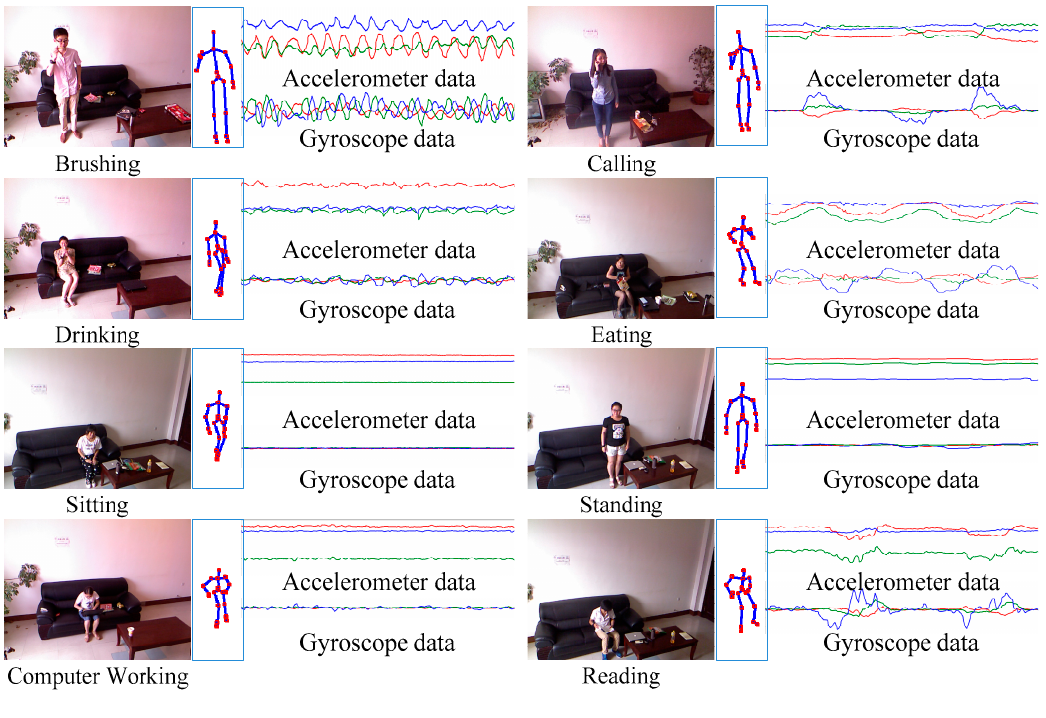
Figure 5. Data collection.